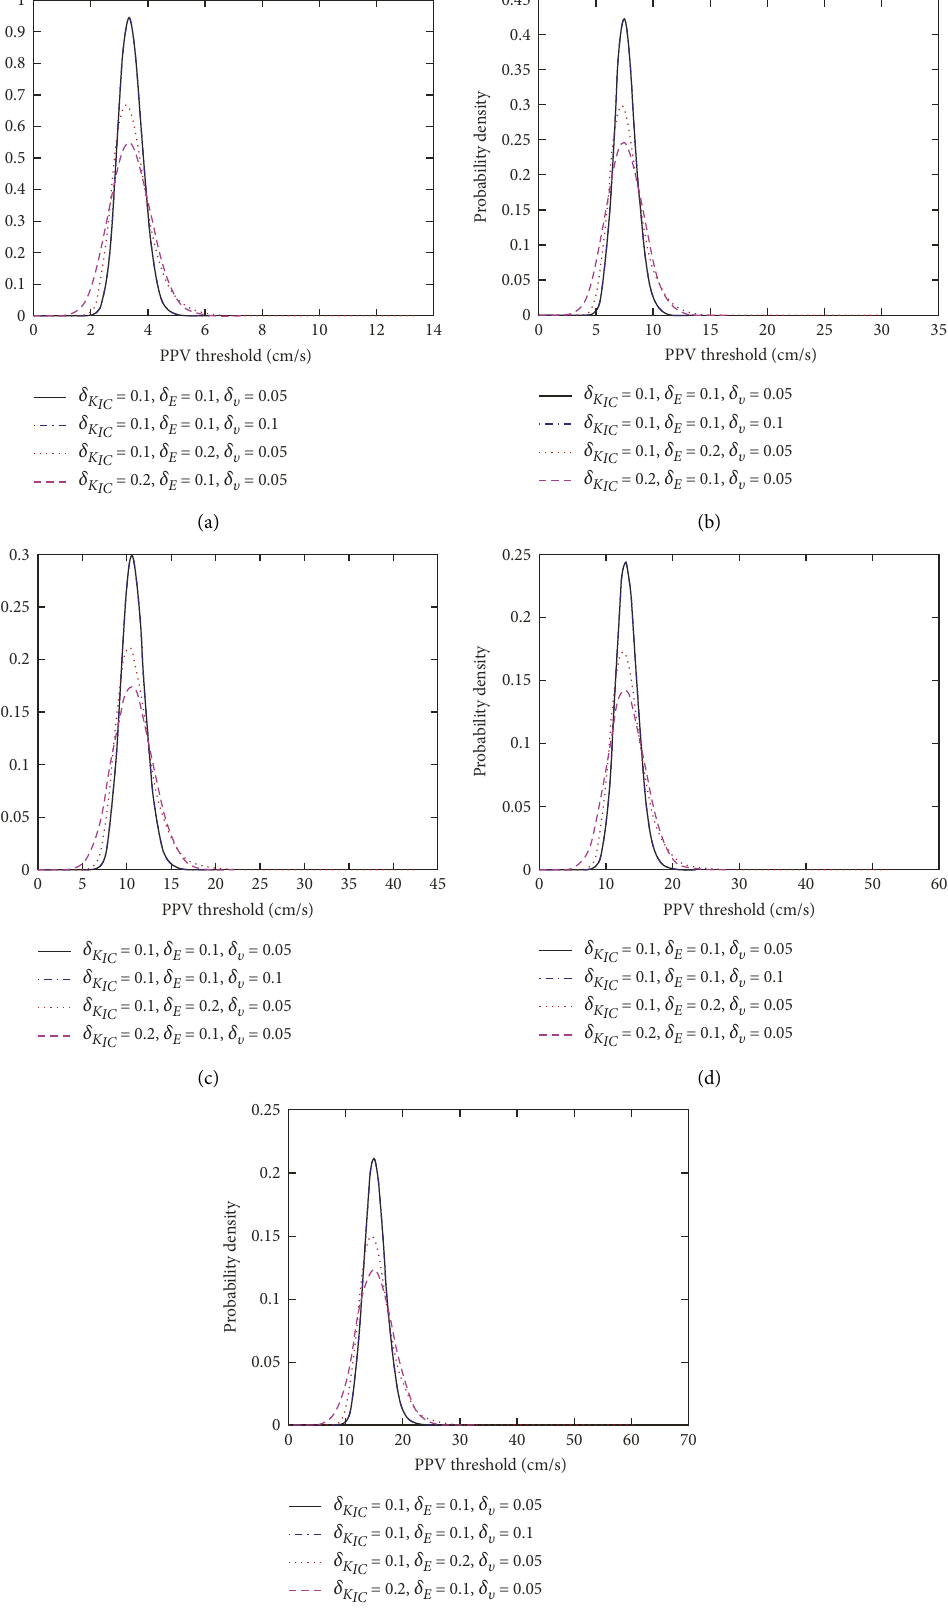
Figure 7: PDF of PPV threshold for different frequencies. (a) 10Hz, (b) 50Hz, (c) 100Hz, (d) 150Hz, and (e)